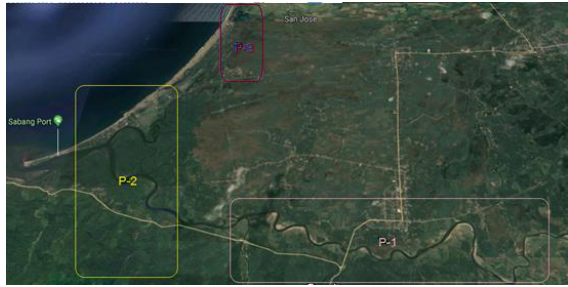
Fig. 3. Portions of Flood Affected Areas.